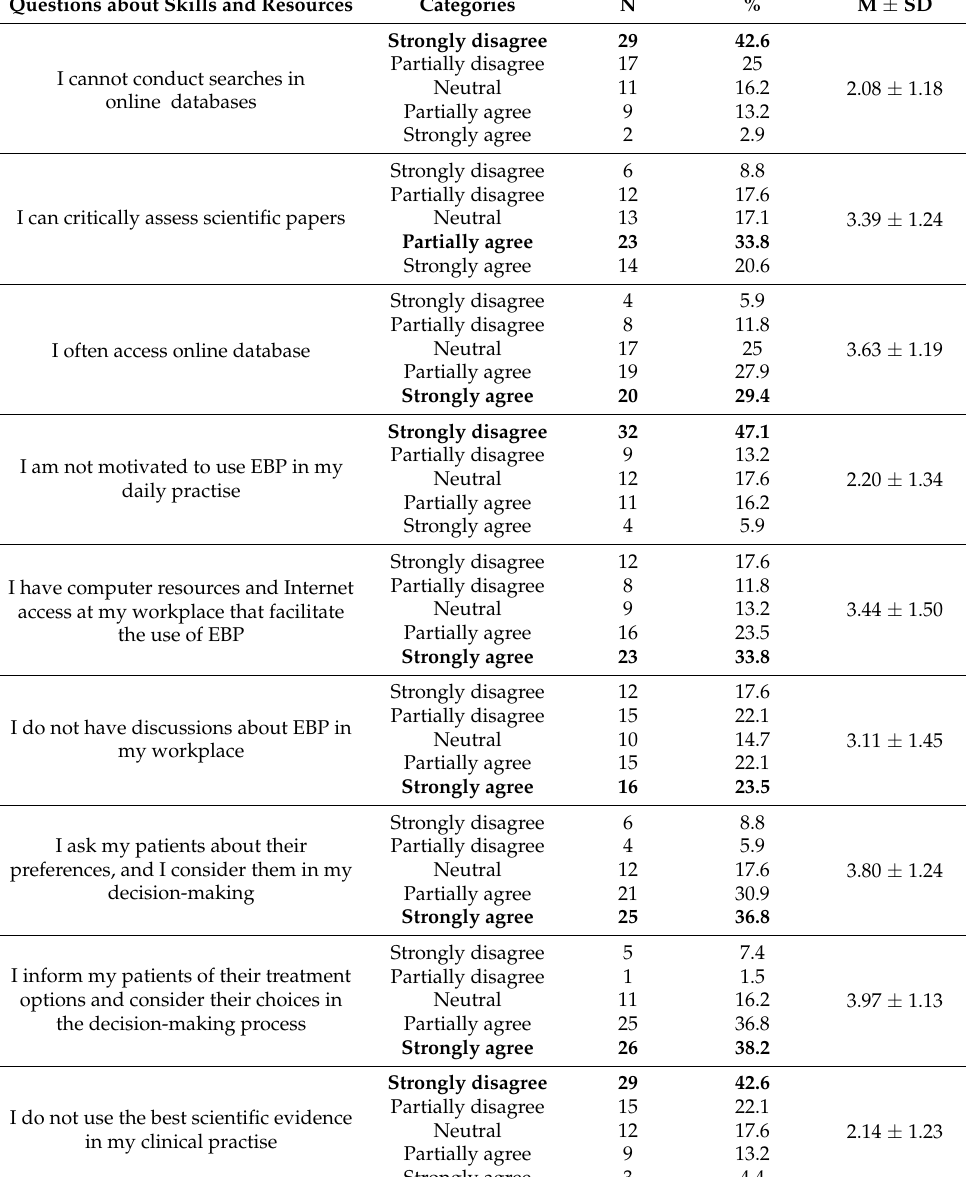
Table 3. Self-reported characteristics related to EBP—skills and